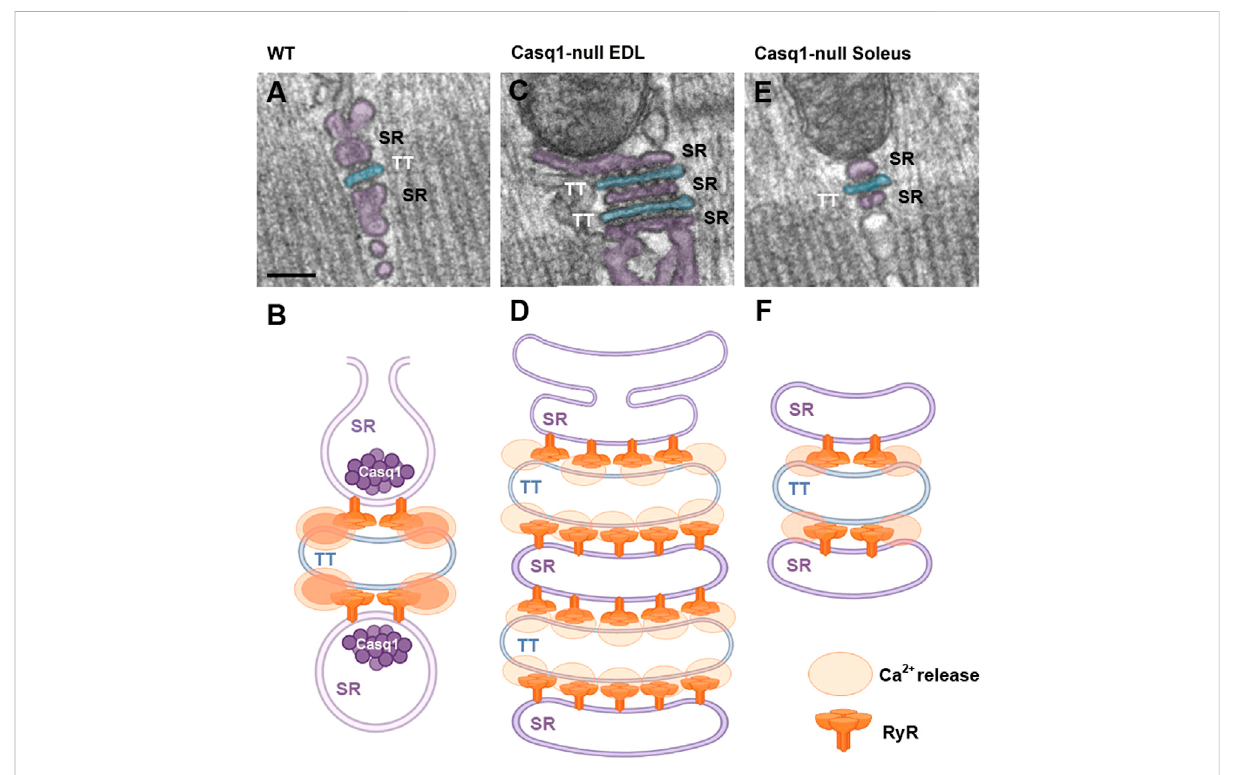
FIGURE 1 Representative EM images and schematic cartoons depicting CRUs in WT and Casq1-null fi bers. (A,B) In WT fi bers, CRUs are formed by three elements (2 SR terminal cisternae fl anking a central TT), SR has a wide pro fi le and contains a dark matrix representing Casq. RyRs usually form two rows spanning the junctional gap between SR and TT. (C – F) In Casq1-null fi bers SR terminal cisternae are signi fi cantly narrower than in WT as they lack Casq-matrix; in EDL fi bers CRUs are often formed by multiple elements decorated by multiple rows of RyRs. Scale bars: (A, C, E) , 0.1 μ